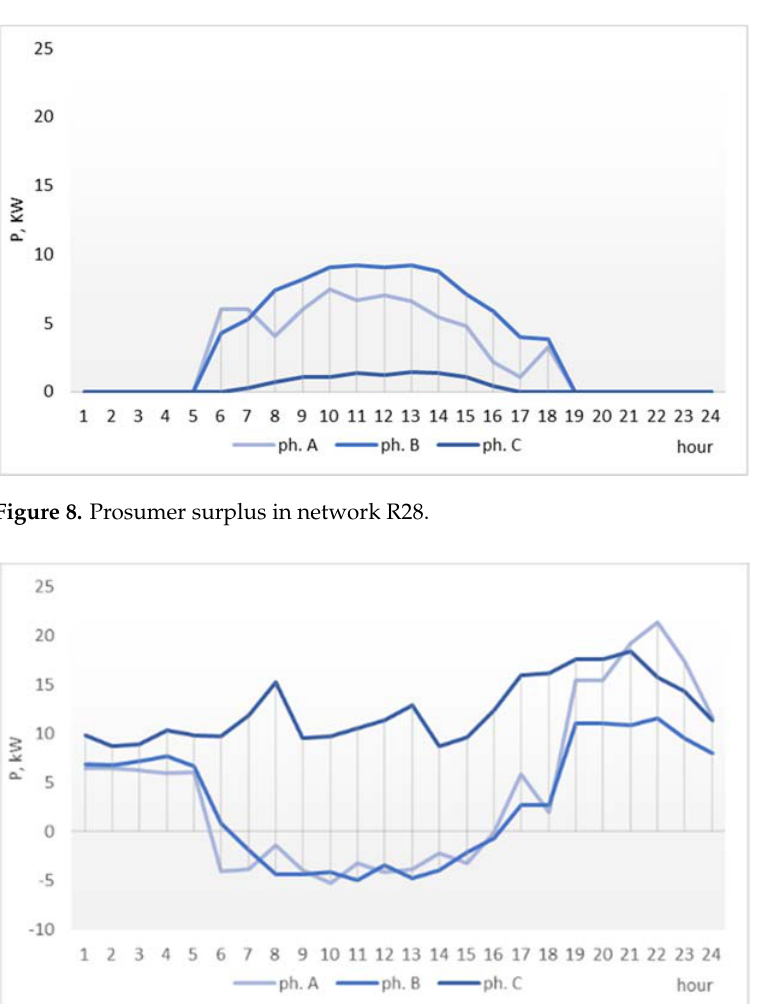
Figure 7. Generation in network R28.